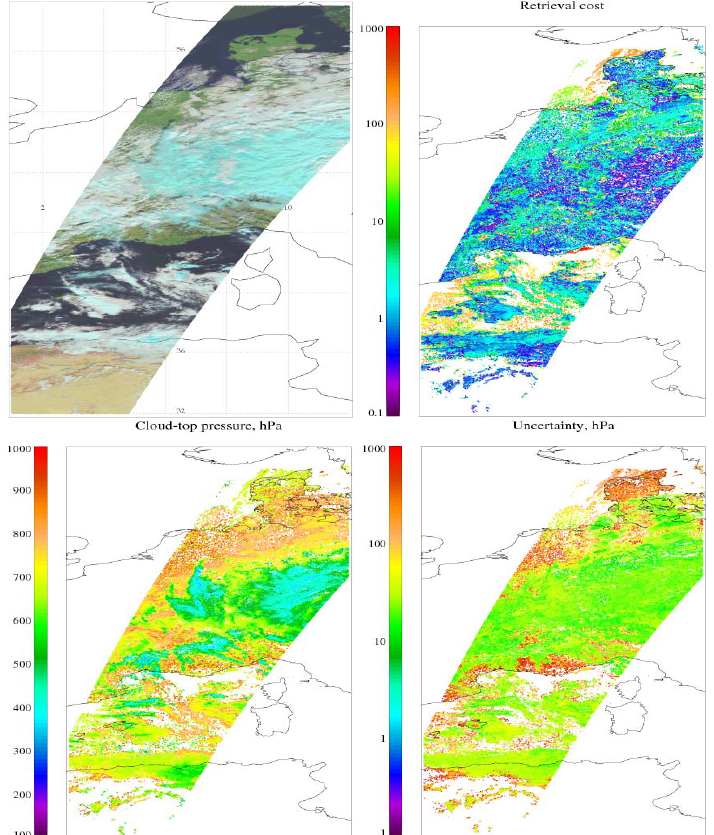
Fig. 6. False colour image of clouds over Europe from ATSR-2 on the 10 November 1999. The pale blue colour results form absorption in the 1.6µm channel and is an indicator of ice phase or very thick clouds (top left), cost of the retrieval (top right). Cloud top pressure (bottom left) and error on cloud top pressure (bottom right), The white area within the swath shows where the region has been designated cloud free using the cloud